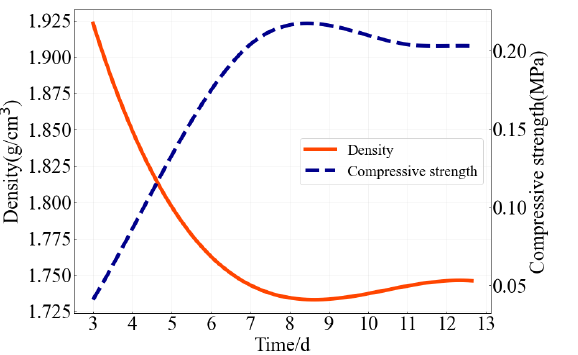
Figure 4. Relation curve between density, compressive strength and curing time of similar materials. Note: The variation law of deformation modulus is basically the same as that of compressive